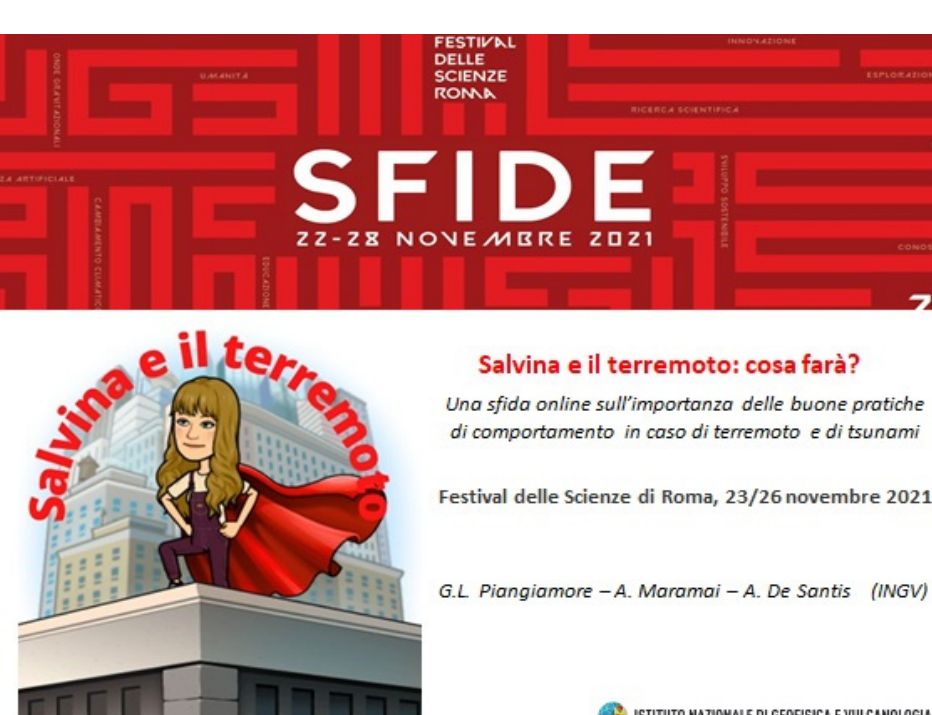
Figure 2. Representative image of the Salvina and the earthquake: what will she do? an online race on the importance of good practice in case of earthquake and tsunami, played online at the Science Festival of Rome 2021 .